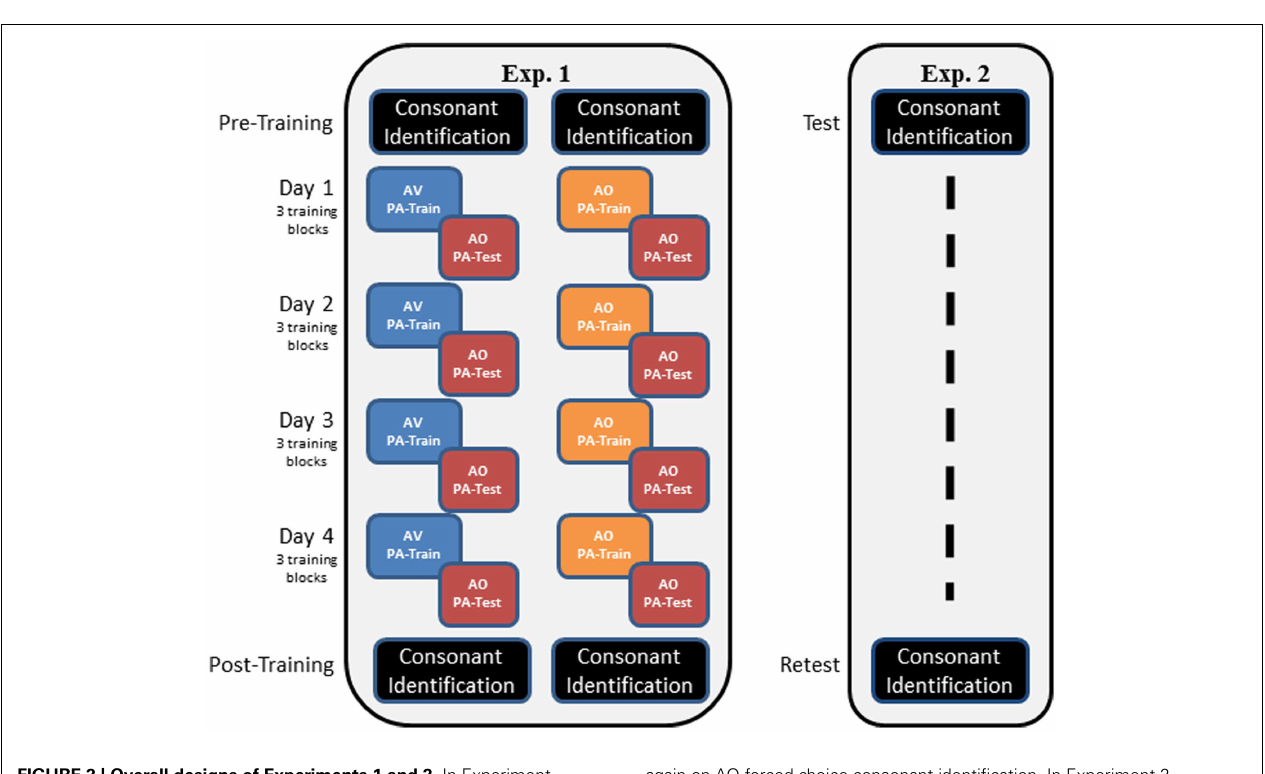
FIGURE 2 | Overall designs of Experiments 1 and 2. In Experiment 1, participants carried out pre-training consonant identification, followed by either AV or AO training on four stimulus lists, with AO tests on each list.Training of three blocks per list was carried out on a separate day for each list. Post-training, participants were tested